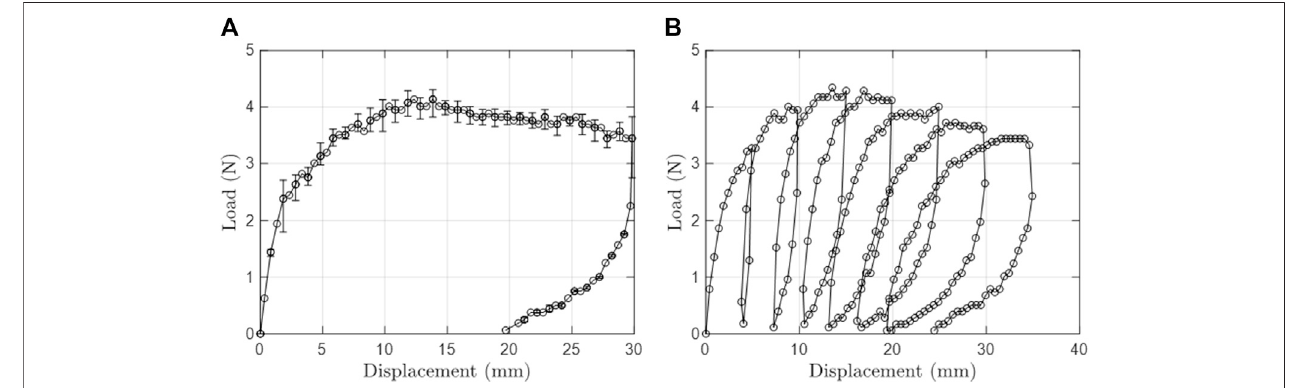
FIGURE 7 | Experimental load-displacement curve (A) one loading/unloading, (B) several